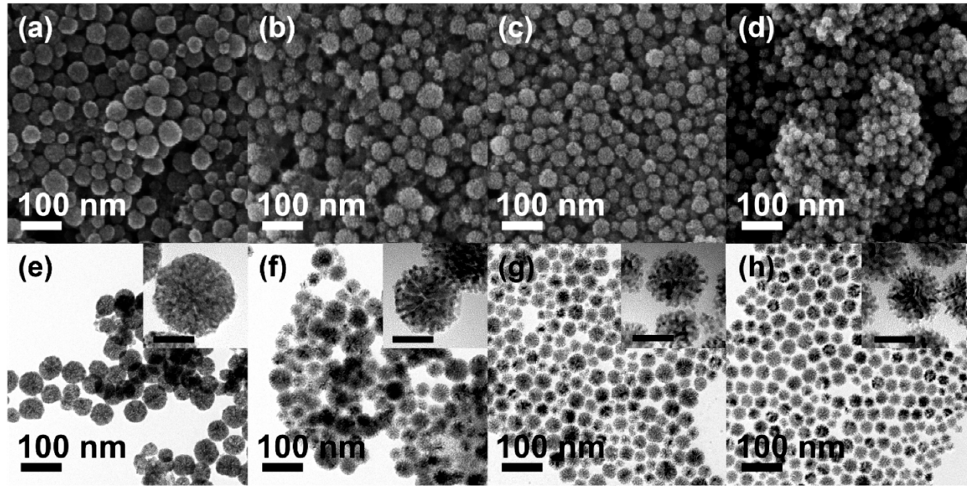
Figure 2. SEM and TEM images of Pd–Pt NDs with controlled CTAC concentration representative to ( a ); ( e ) Pd–Pt–10 CTAC NDs, ( b ); ( f ) Pd–Pt–50 CTAC NDs, ( c ); ( g ) Pd–Pt–100 CTAC NDs, and ( d ); ( h ) Pd–Pt–200 CTAC NDs. Scale bar in the inset figures of parts e–h is 30 nm.